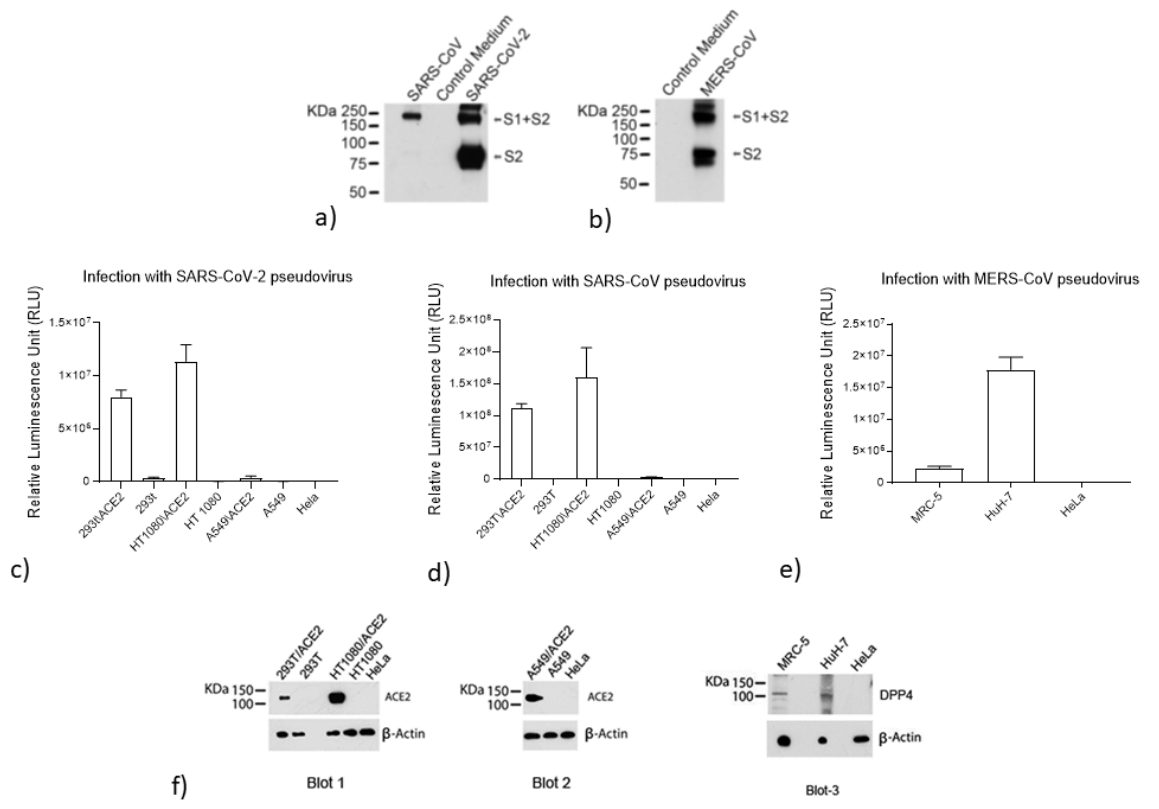
Figure 2. Validation of the SARS-CoV-2, SARS-CoV, and MERS-CoV pseudoviruses and ACE2 and DPP4 expression in different cell lines. ( a ) Immunoblot to validate the incorporation of the spike (S) protein in the SARS-CoV and SARS-CoV-2 pseudoviruses ( b ) Immunoblot to validate the incorporation of the spike (S) protein in the MERS-CoV pseudovirus Infection of cells expressing different levels of angiotensin-converting enzyme 2 (ACE2) with ( c ) the same amounts of SARS-CoV-2 or ( d ) SARS-CoV pseudovirus. ( e ) Infection of cells expressing different levels of dipeptidyl peptidase 4 (DPP4), with the same amounts of MERS-CoV pseudovirus. Columns represent the means ± standard deviations ( n = 4). ( f ) Immunoblot of cell lysates to evaluate ACE2 expression (Blot 1 and Blot 2) and DPP4 expression (Blot 3). β -Actin was used as a loading control.